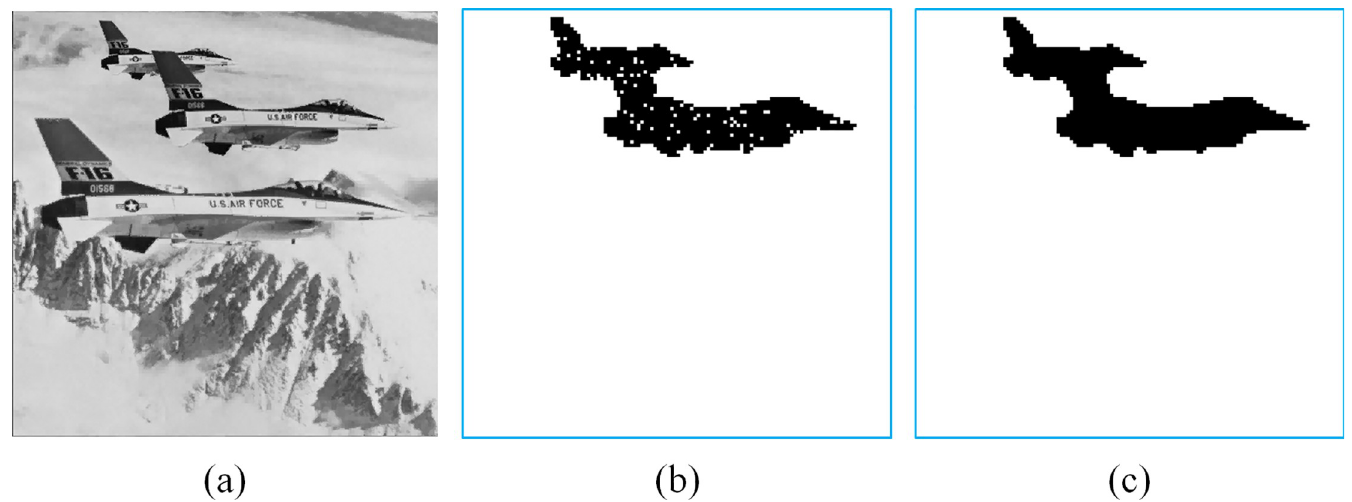
Fig 5. Detection of a tampered image. (a) Tampered Jet image. (b) First stage detection. (c) Second stage detection.